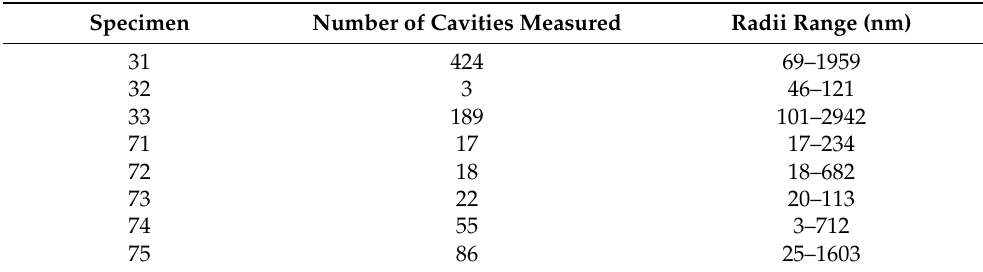
Table 5. Measured cavity radii by